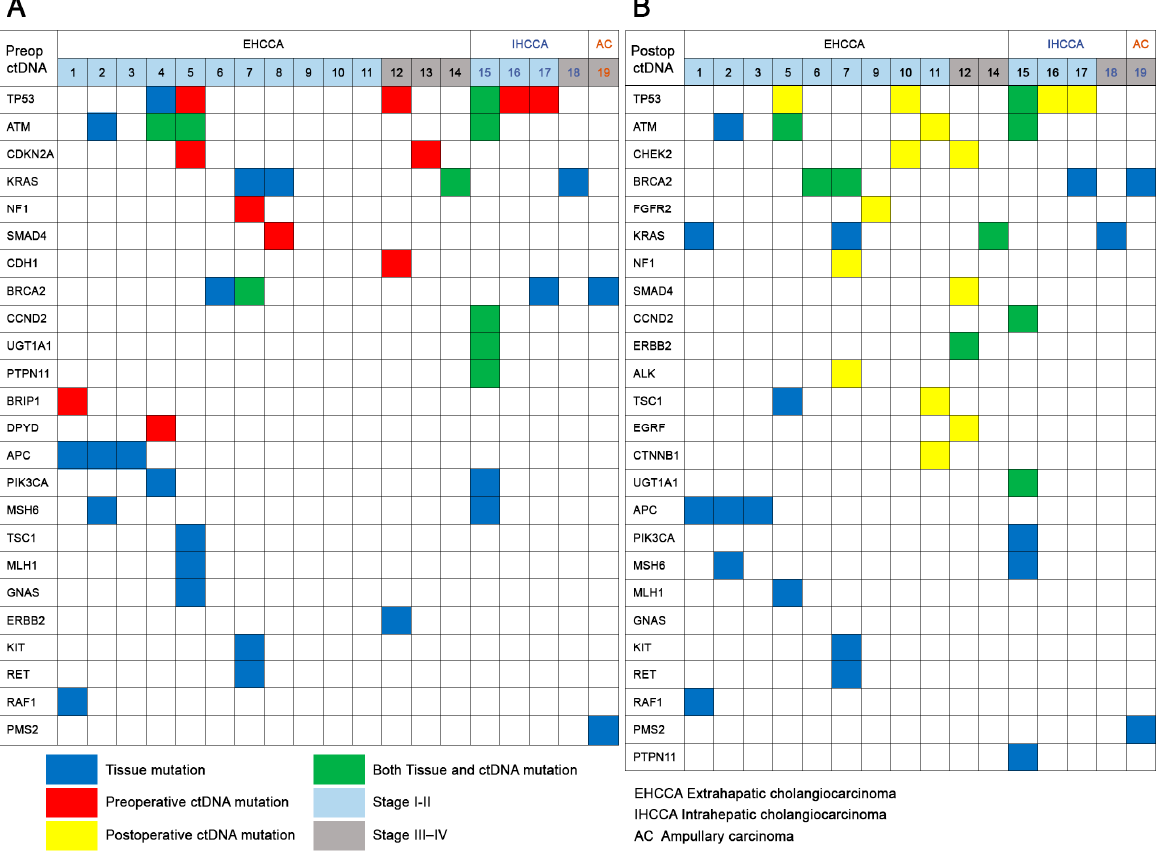
Figure 5. Distribution of somatic mutations in ( A ) preoperative and ( B ) postoperative plasma and corresponding tissue samples.